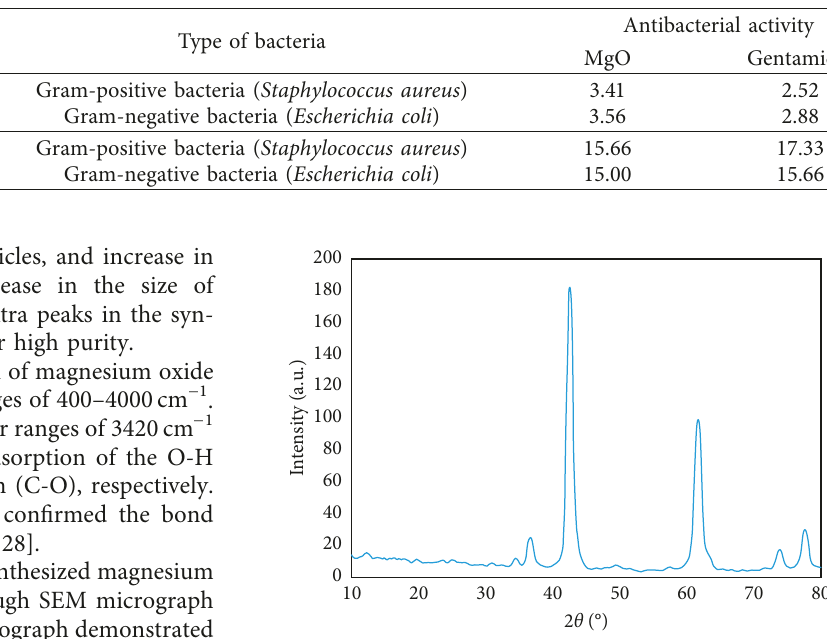
Table 6: The antibacterial activity of synthesized MgO nanoparticles in optimal conditions proposed by Taguchi method.